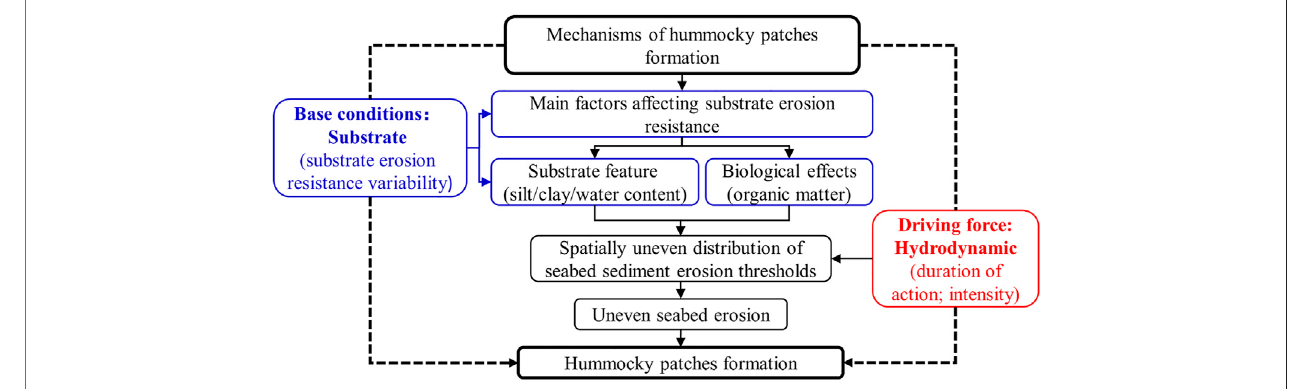
FIGURE 11 | Conceptual model of hummocky patches formation mechanism.